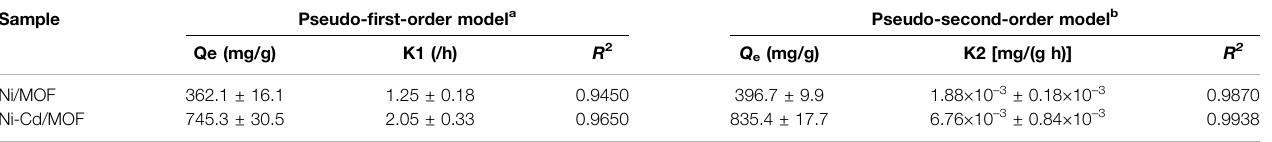
TABLE 1 | Regression parameters of kinetic models for Pb 2+ adsorption on two different MOFs.